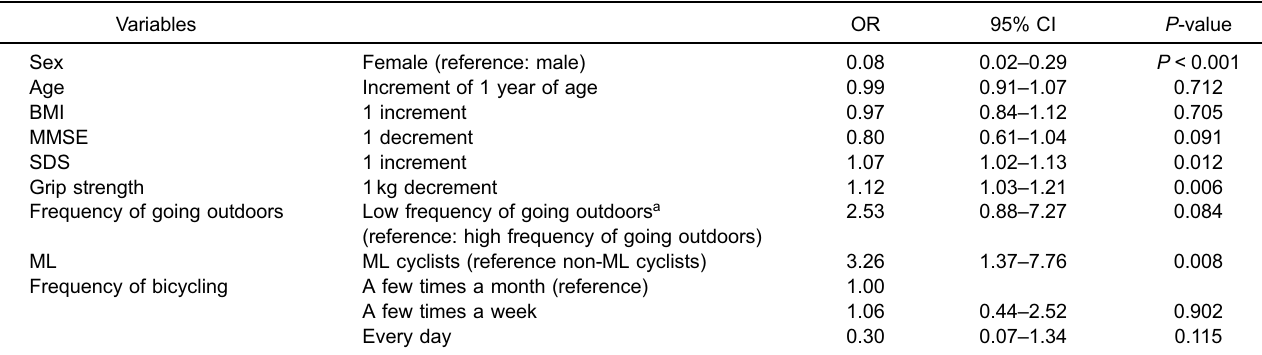
Table 4. Logistic regression analysis of the risk factors for bicycle-related falls among older cyclists ( n = 399)